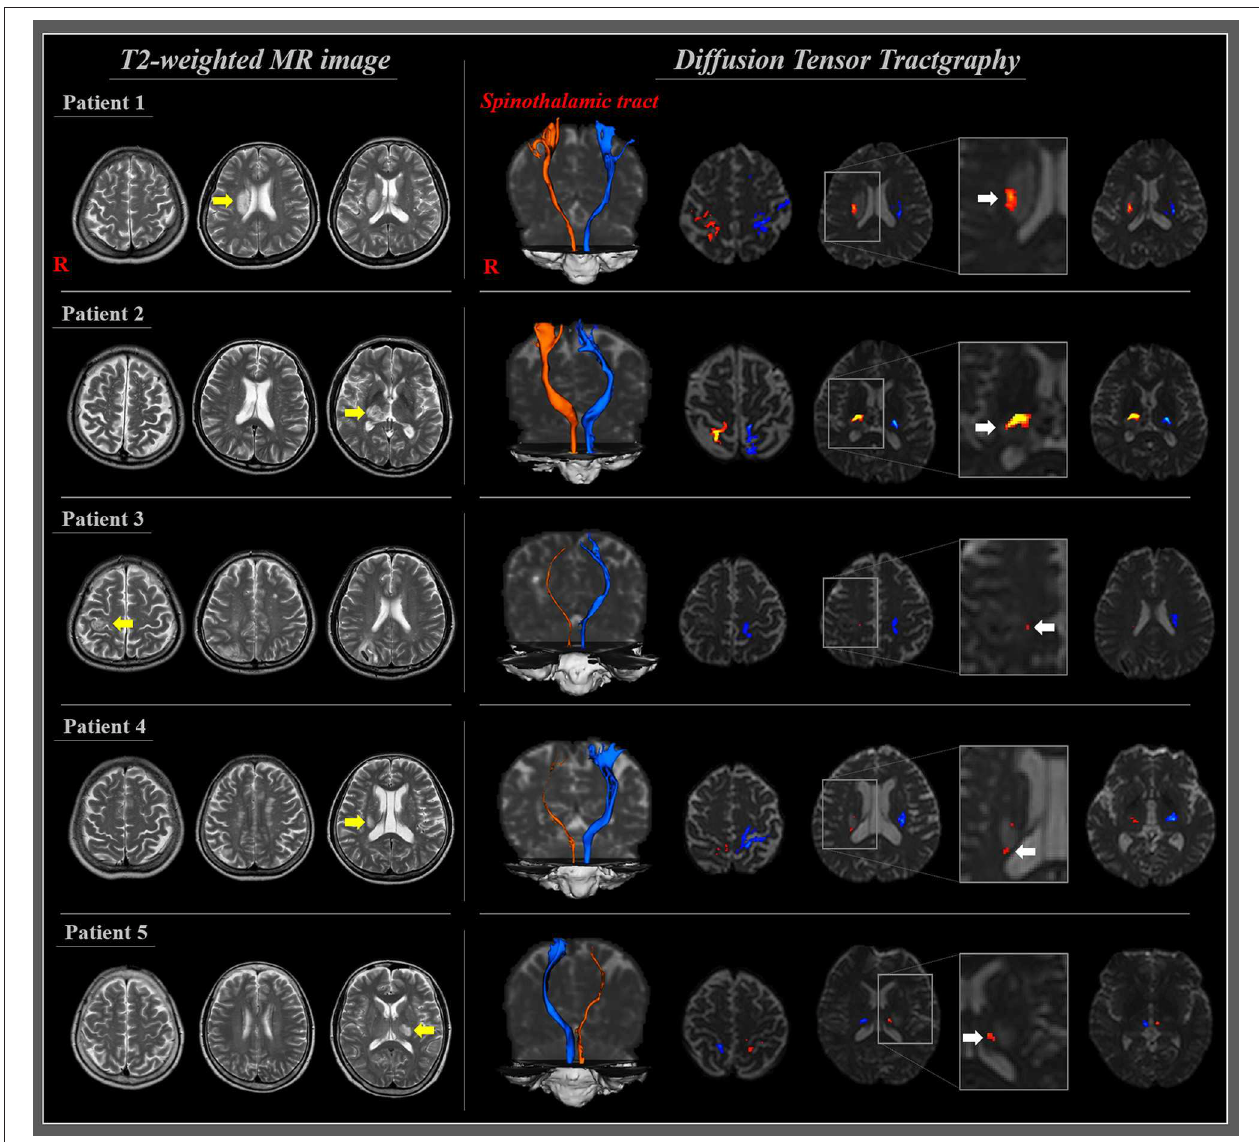
FIGURE 2 | T2-weighted MRI and diffusion tensor tractography of patients with CPSP following cerebral infarction. T2-weighted MR images of five patients with cerebral infarction (yellow arrows). Diffusion tensor tractography of five patients at 11 days on average after stroke onset; all the reconstructed spinothalamic tracts in the affected hemisphere originated from the posterolateral medulla and terminated at the primary somatosensory cortex through adjacent part of the infarct (white arrows) and narrowing in three patients (patients 3, 4, and 5) [reprinted with permission from Jang et al. (30)].